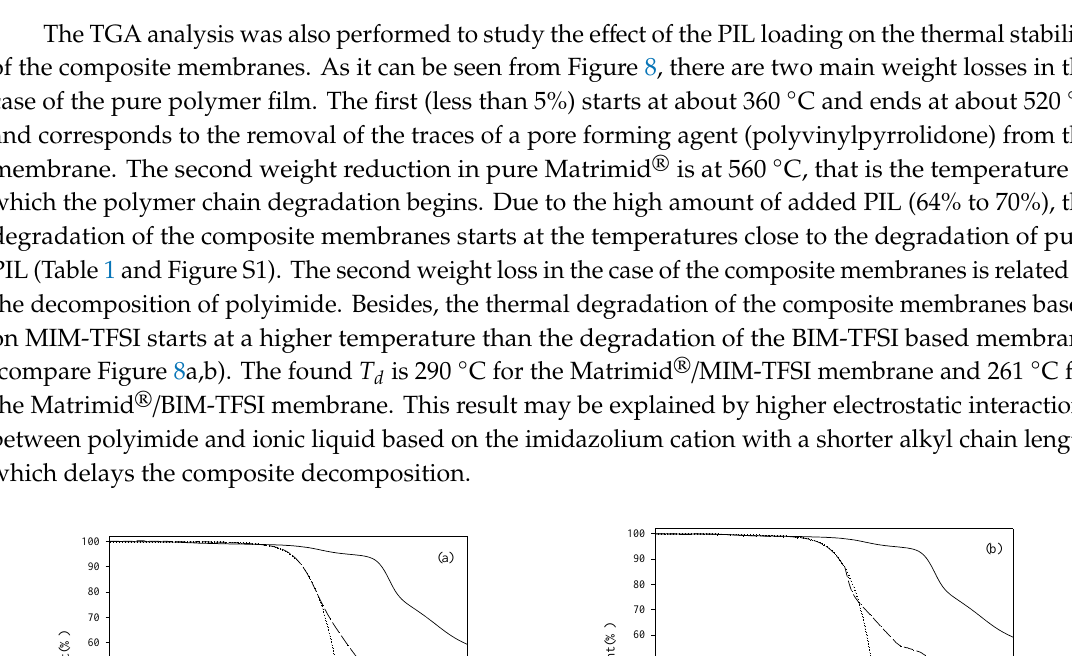
Figure 7. FTIR spectra of (1) Matrimid ® film, (2) MIM-TFSI, (3) BIM-TFSI, (4) Matrimid ® /MIM-TFSI membrane, (5) Matrimid ® /BIM-TFSI membrane.